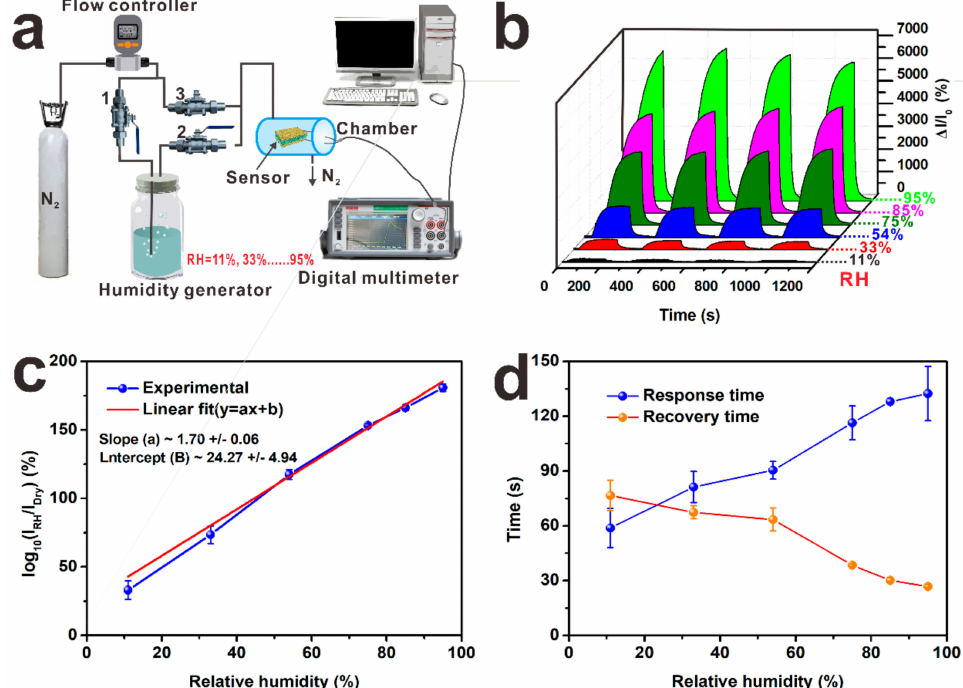
Figure 3. ( a ) Homemade humidity test system. ( b ) The repeatability characteristic of Ag@Fe 3 O 4 -MS at RH = 11–95%. The specimen dimensions are 20 mm length and 15 mm width. ( c ) Plot of log10 ( I RH / I Dry ) for Ag@Fe 3 O 4 -MS versus relative humidity (RH). ( d ) Responses of the sensor with respect to RH.